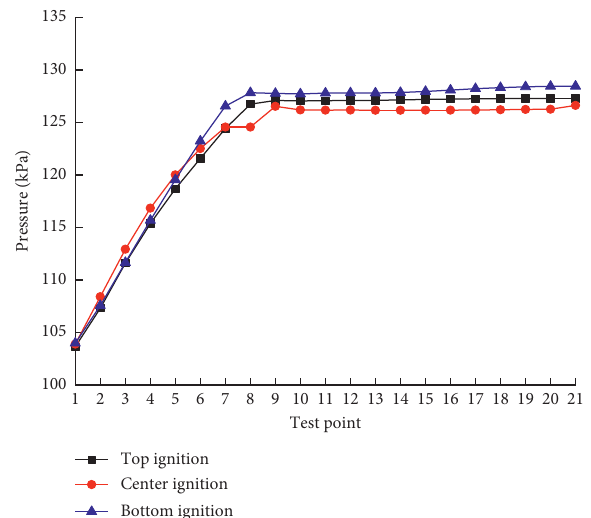
Figure 5: Curves of peak pressure under different ignition positions.